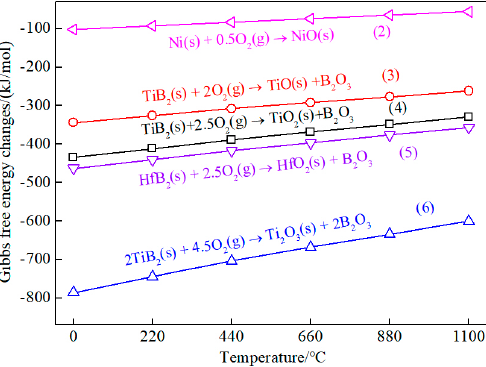
Figure 6. Variations of the Gibbs free energy for the oxidation reactions of Ni, TiB 2 , and HfB 2 at 0 − 1100 °C.